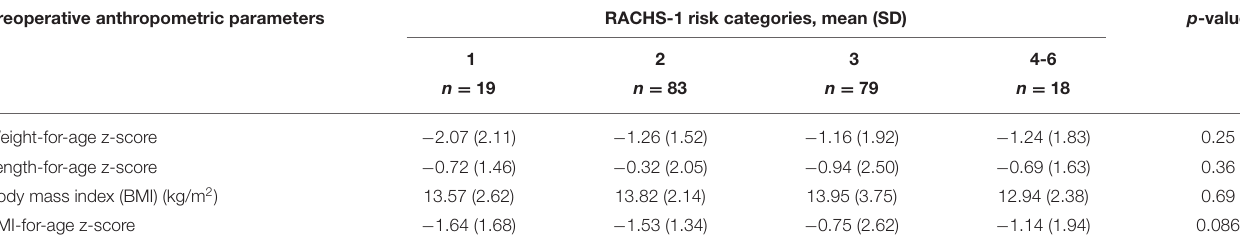
TABLE 2 | Summary of preoperative anthropometric parameters by Risk Adjustment for Congenital Heart Surgery (RACHS) − 1 risk categories. Preoperative anthropometric parameters